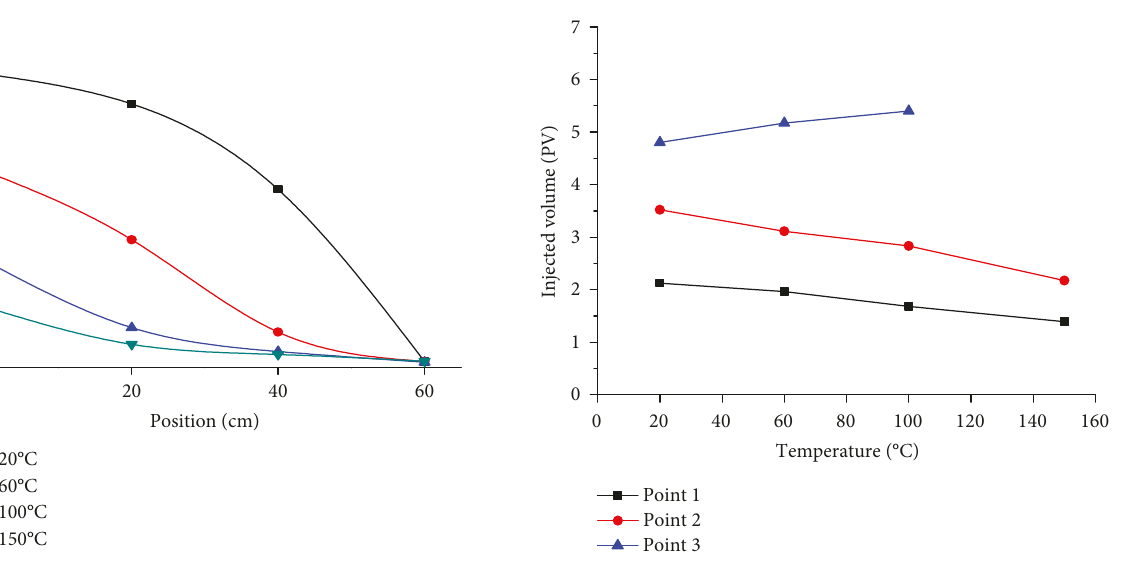
Figure 7: Change of foam arrival time with the temperature at di ff erent positions